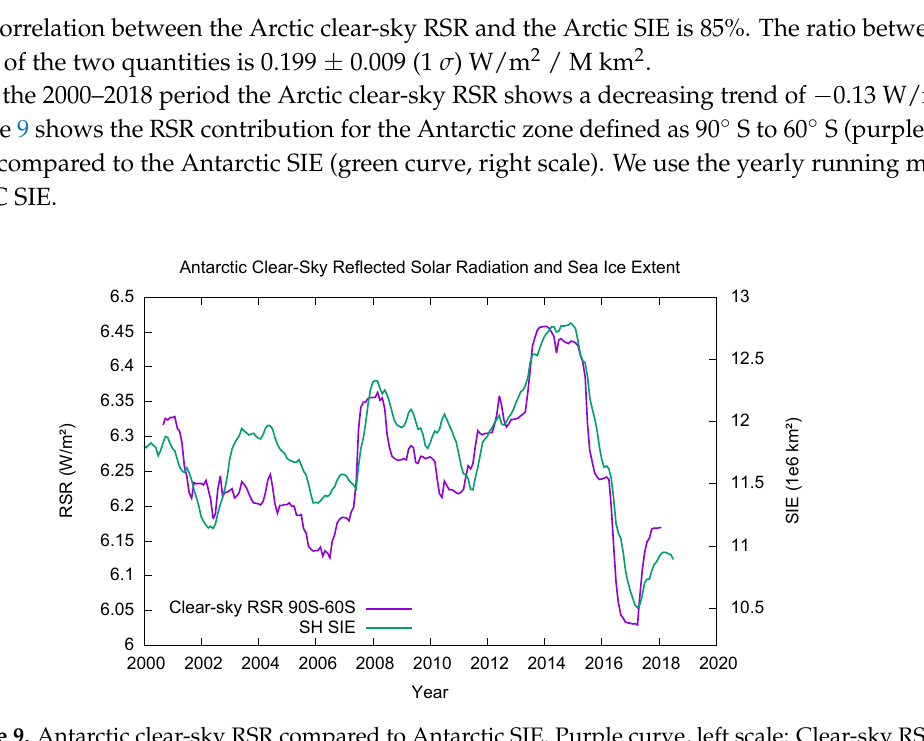
Figure 9. Antarctic clear-sky RSR compared to Antarctic SIE. Purple curve, left scale: Clear-sky RSR contribution of zone from 90 ◦ S to 60 ◦ S. Green curve, right scale: Antarctic SIE. The correlation between the Antarctic clear-sky RSR and the Antarctic SIE is 88%. The ratio between the variations of the two quantities is 0.17 ± 0.006 (1 σ ) W/m 2 /M km 2